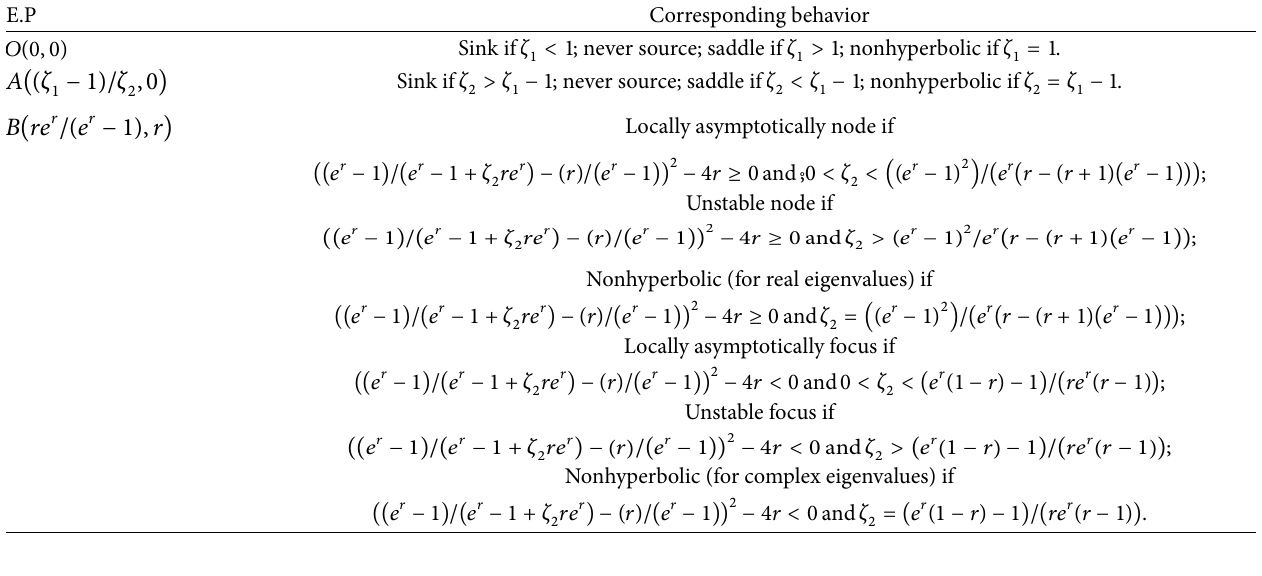
Table 1: Number of equilibria along their qualitative behavior of